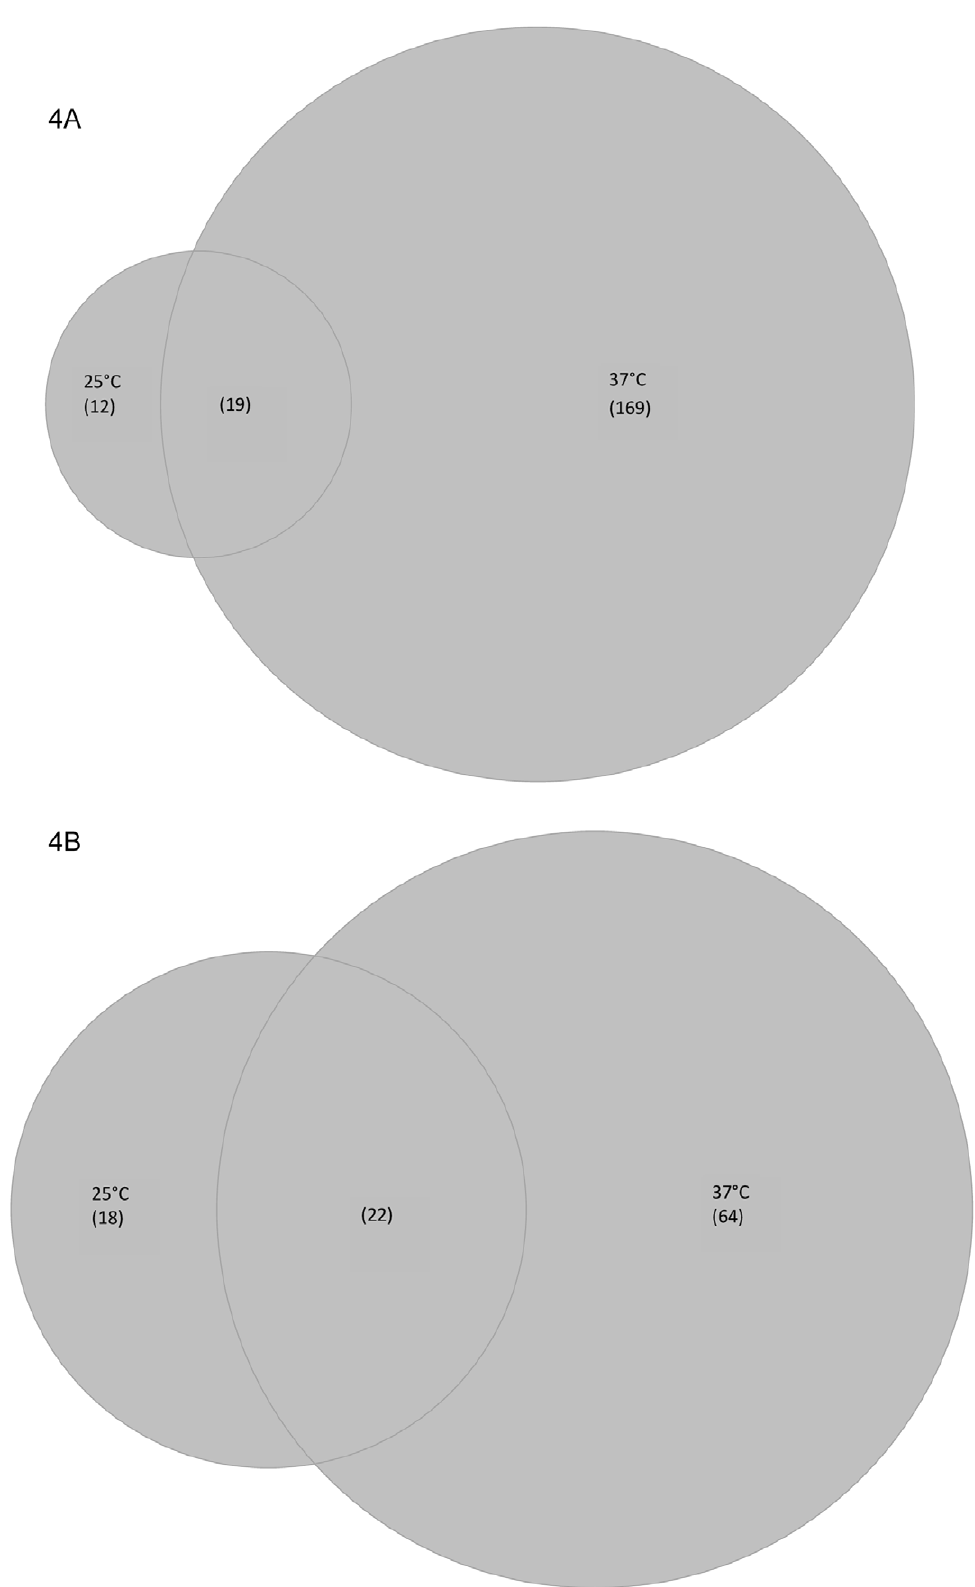
Figure 4. Venn diagrams of genes with significant differences in the comparison DG125A versus EGD-e at 25 6 C and 37 6 C. (A) genes with higher transcript levels; (B) genes with lower transcript levels.